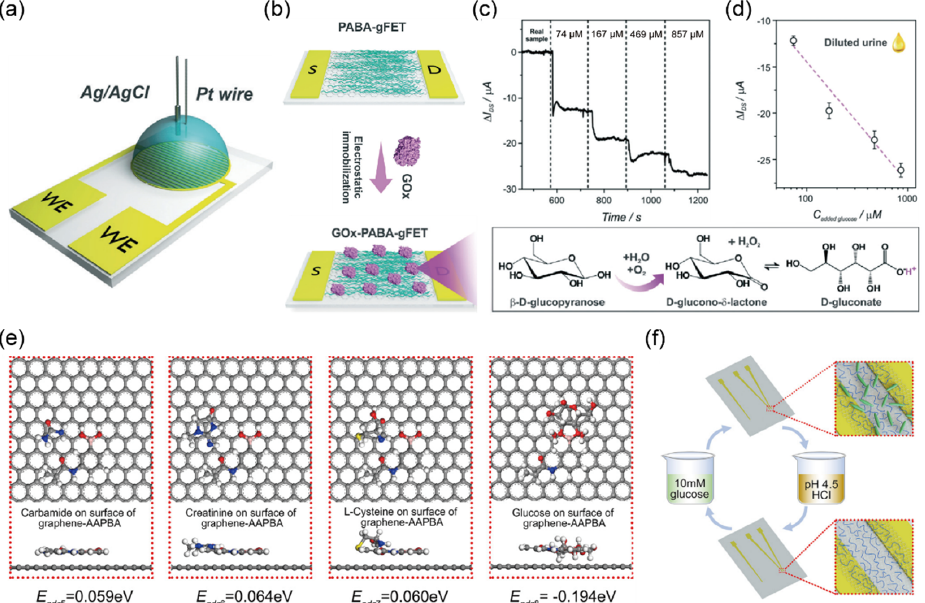
Figure 2. Selective detection of glucose in biological samples using GFET biosensor ( a ) Illustration of the experimental setup to perform poly(3 ‐ amino ‐ benzylamine ‐ co ‐ aniline) (PABA) electropoly ‐ merization on the graphene field ‐ effect transistor (GFET). Source and drain electrodes are used as working electrodes of a three ‐ electrode cell. The platinum wire and Ag/AgCl are used as counter and reference electrodes, respectively. ( b ) Overview of glucose oxidase (GOx) immobilization in PABA ‐ GFETs and the glucose oxidation reaction. ( c ) Real ‐ time electrical current measurement of the sensor after injection of spiked urine samples (V G = − 0.2 V, V DS = 0.1 V) and ( d ) curve fitting using the linear response of sensitivity of –13 ± 2 µA per decade of glucose concentration (R 2 = 0.9462, n = 2) (reprinted with permission from [30]; copyright 2021 RSC). ( e ) The binding energy of 3 ‐ acrylami ‐ dophenylboronic acid (AAPBA) ‐ functionalized graphene with carbamide, creatinine, l ‐ cysteine, and glucose, respectively. The negative binding energy (–0.194 eV) indicates strong chemical ad ‐ sorption toward glucose. ( f ) Schematic illustration of the recycling detection of the polymer func ‐ tionalized GFET with a simple solution process. The covalent bond between glucose and the poly ‐ mer can be broken under an acid environment. (Reprinted with permission from Ref. [31]; copyright 2022 Elsevier.)